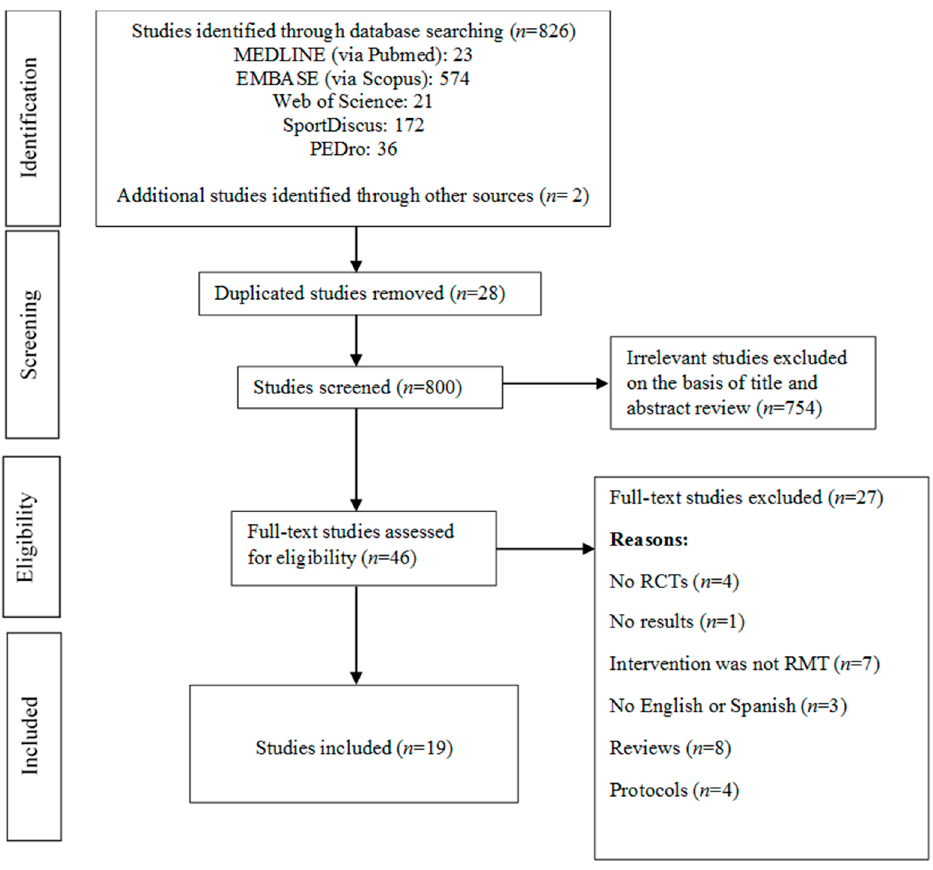
Figure 1. Literature search: Preferred Reporting Items for Systematic Reviews and Meta-Analyses (PRISMA) consort diagram. RMT, Respiratory muscle training; RCTs, randomized controlled trials.